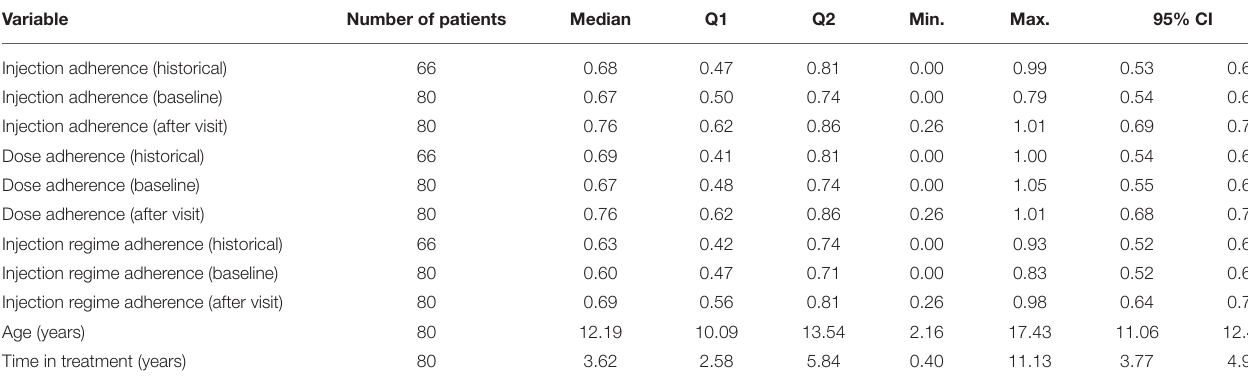
TABLE 3 | Comparison of adherence before and after the educational intervention (nurse visit). Variable